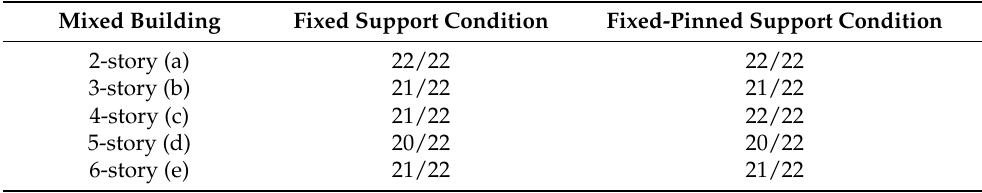
Table 5. The number of failure cases for the mixed buildings of Figure 1. Mixed